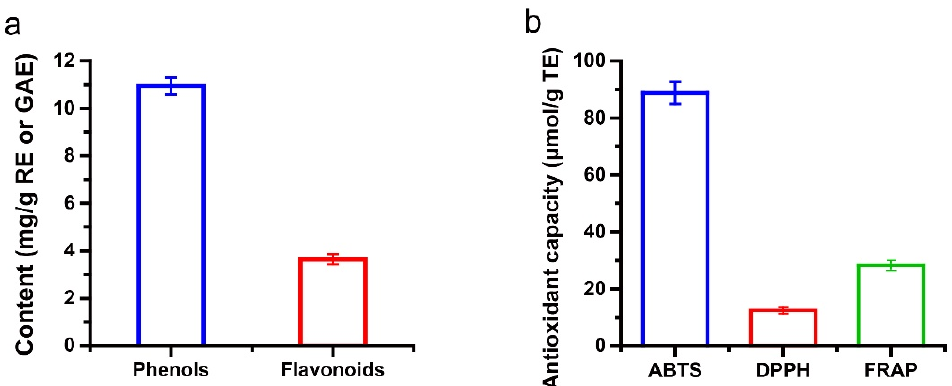
Figure 4. The content of the bioactive components of the CFJ ( a ) and its antioxidant capacity, in vitro ( b ). Table 7. The concentration of the specific phenols and flavonoids contained in the CFJ.